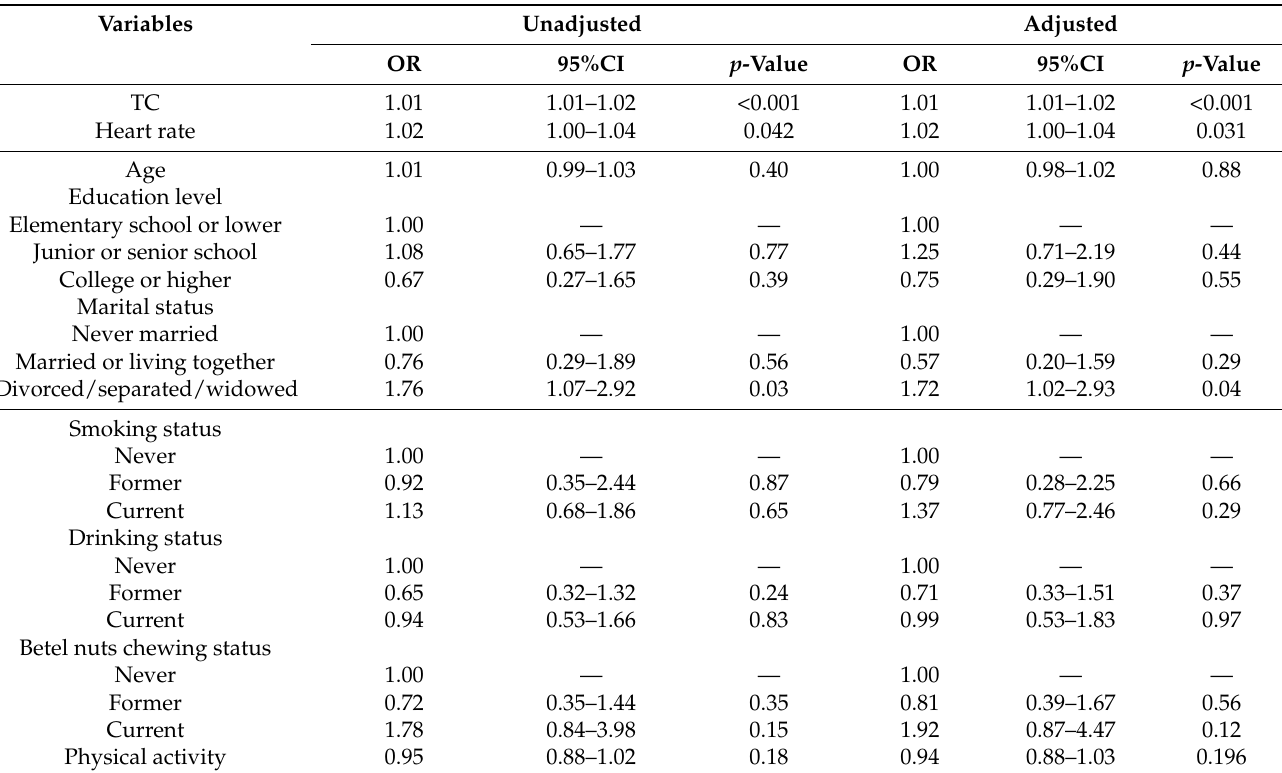
Table 3. Multivariate adjusted odds ratios (ORs) for metabolic syndrome (MetS) after adjustment for potential confounders. Variables